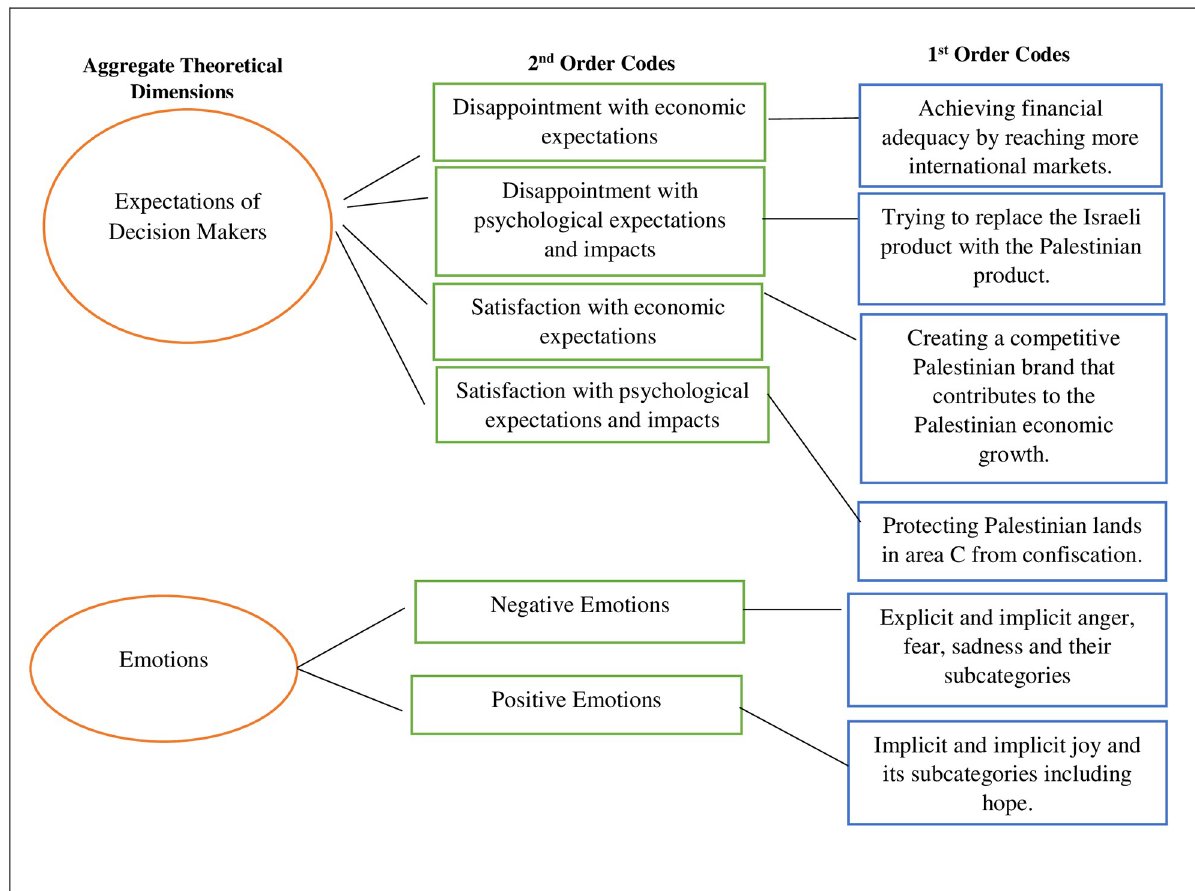
Fig 1. A visualisation of the coding process. Source: